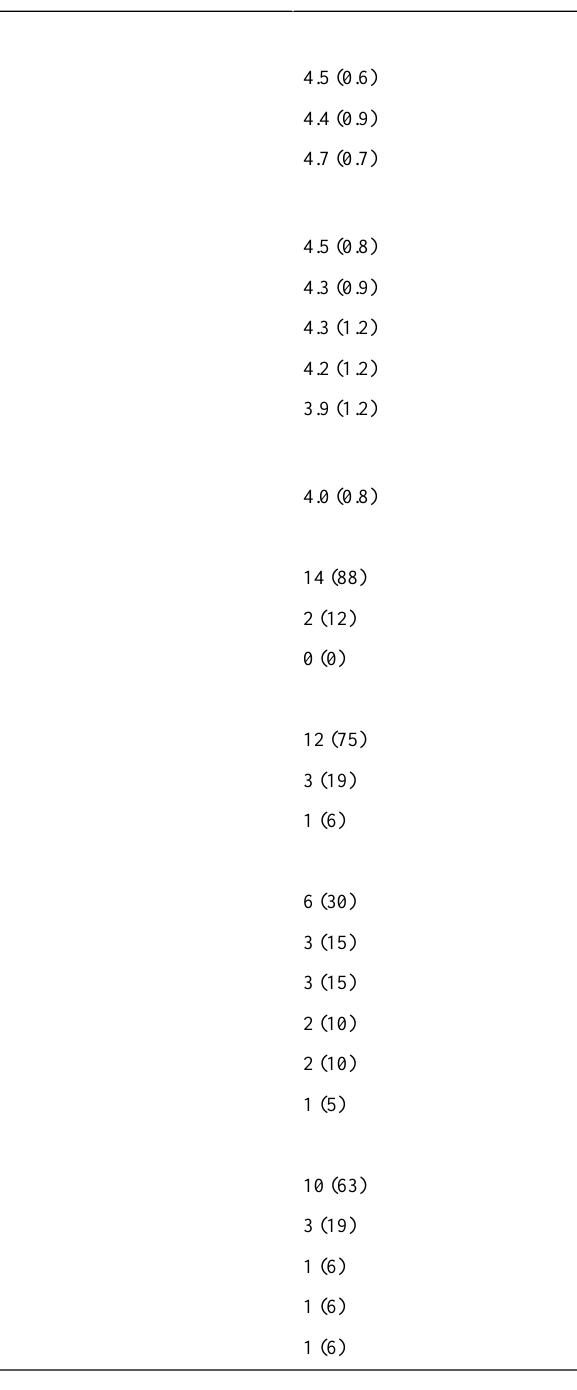
Mean (SD) or n (%)Category and item